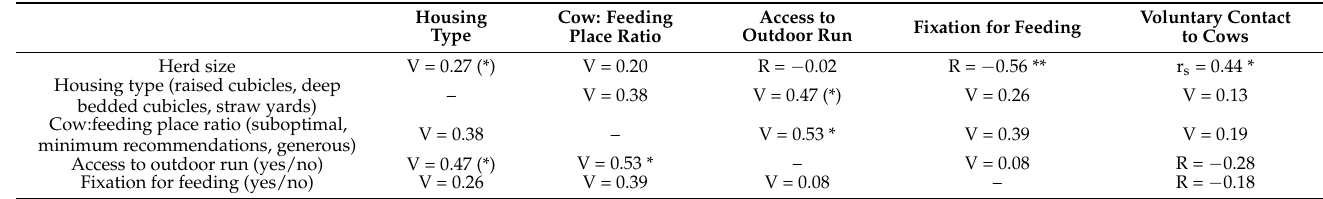
Table A1. Associations between the six factors preselected for multivariable analysis: Spearman rank correlation coefficients (r s , metric/metric), effect sizes R of Wilcoxon tests (R, metric/dichotomous) or Cramer’s V of Kruskal-Wallis and Chi 2 tests (V, metric/categorical, categorical/categorical),